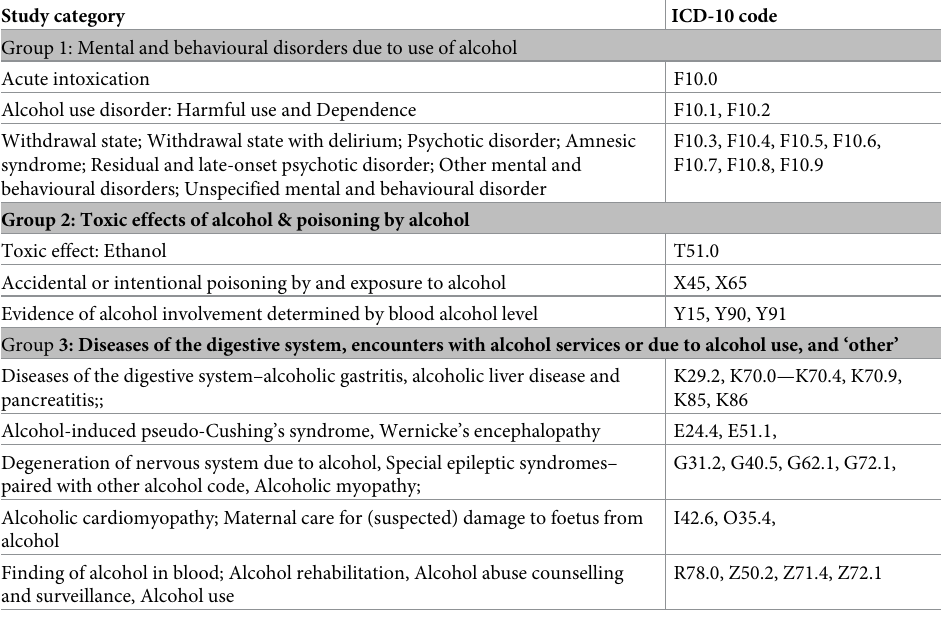
Table 1. ICD-10 defined conditions defined as wholly attributable to